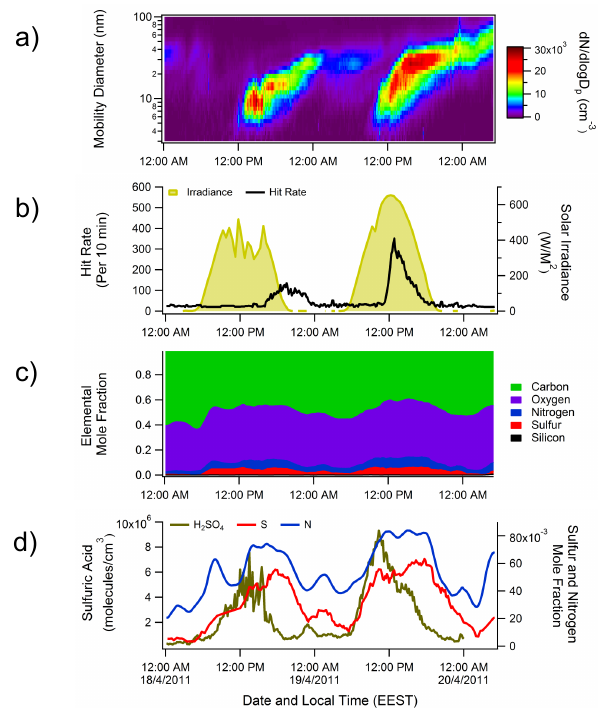
Fig. 1. (a) Particle size distributions for 18 and 19 April 2011. Yellow dashed lines indicate approximate size range analyzed by NAMS. (b) Observed NAMS hit rate (particles analyzed per 10min period; black) and solar irradiation (yellow). (c) Elemen- tal mole fractions measured by NAMS, averaged over 10min peri- ods; plots were subjected to 10-point boxcar smoothing. (d) NAMS- measured sulfur mole fraction (red) and nitrogen mole fraction (blue) and CIMS-measured gas-phase sulfuric acid concentration (yellow-green). Mole fraction plots were subjected to 10-point box- car